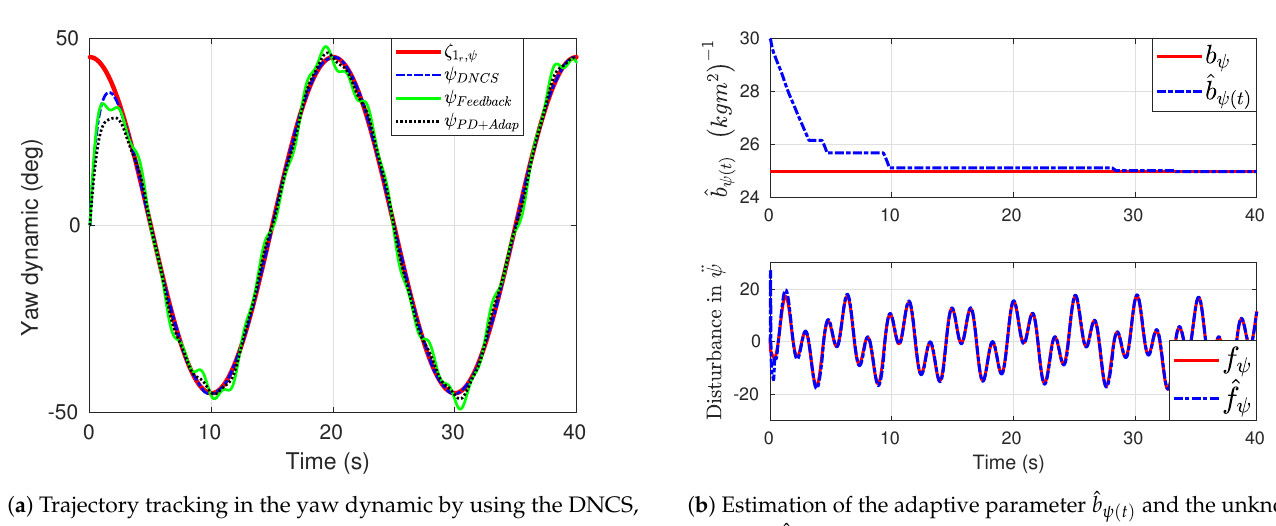
( b ) Estimation of the adaptive parameter ˆ b ψ ( t ) and the unknown function ˆ f ψ . Figure 3. Simulation results for trajectory tracking in yaw dynamic.